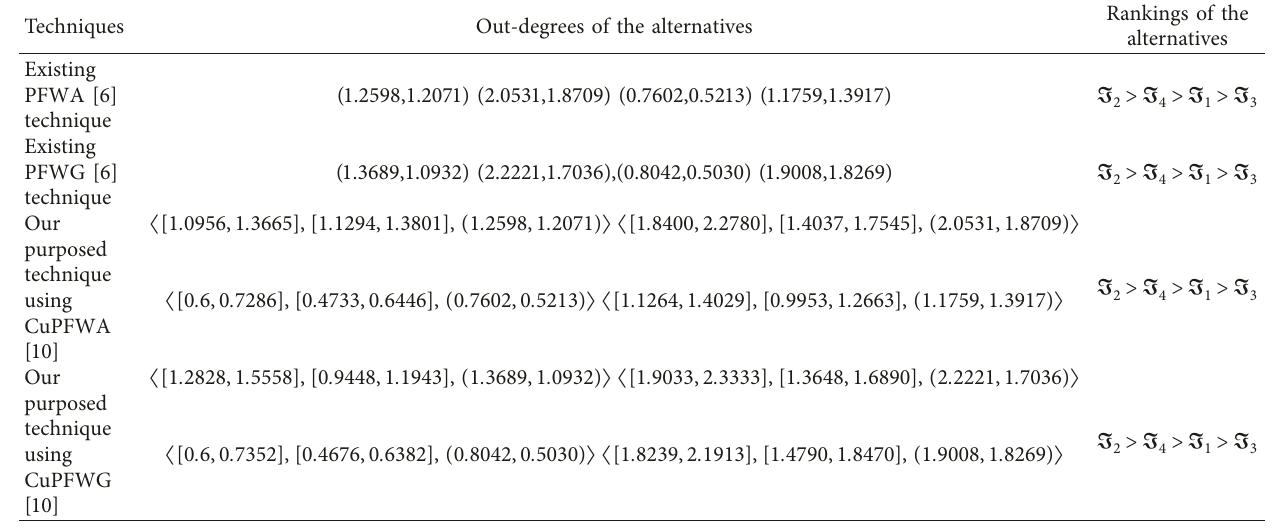
Table 6: Comparative analysis with existing